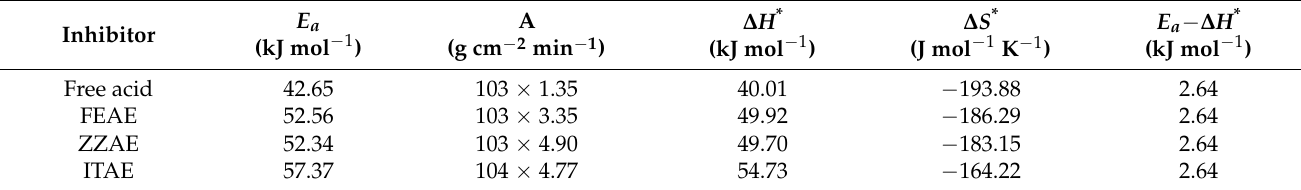
Table 7. Corrosion activation parameters for mild steel in 2 M H 3 PO 4 with and without 2.5 g L − 1 of the studied plant